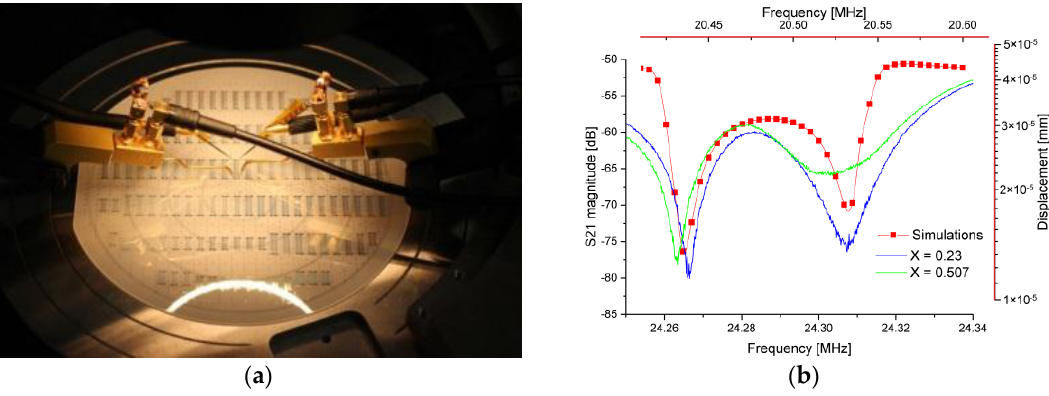
Figure 5. ( a ) Wafer scale measurement setup for the conduction of the sensor experimental investigations; ( b ) Theoretically simulated structure response taken as a displacement magnitude (red marked curve, red marked axis) for deionized (DI) water (speed of sound 1500 m/s) and measured sensor response for the liquid mixtures of DI water and 1-propanol of molar fraction X = 0.23 (blue curve, bottom X-axis) and X = 0.507 (green curve, bottom X-axis).